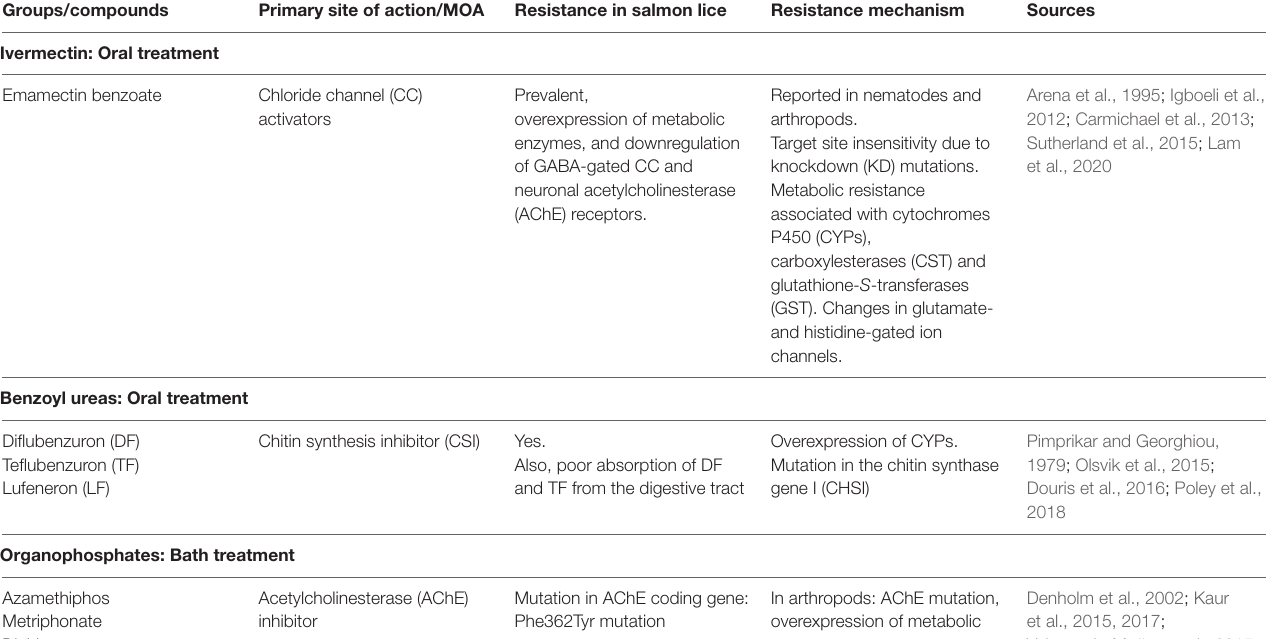
TABLE 2 | Chemicals, Vaccines, and Repellents used in salmon lice control, as well as the concerns associated with them.